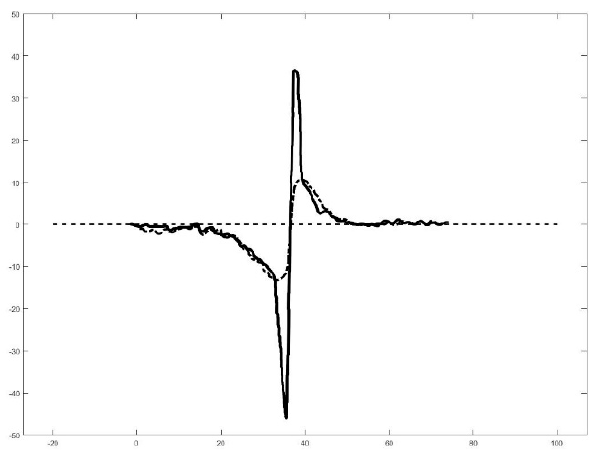
Figure 19. Dashed line is absorption signal from dry coal as a result of naturally present protons. The solid line follows the ingress of water. Notice the shoulder on the solid line as a result of the original protons.